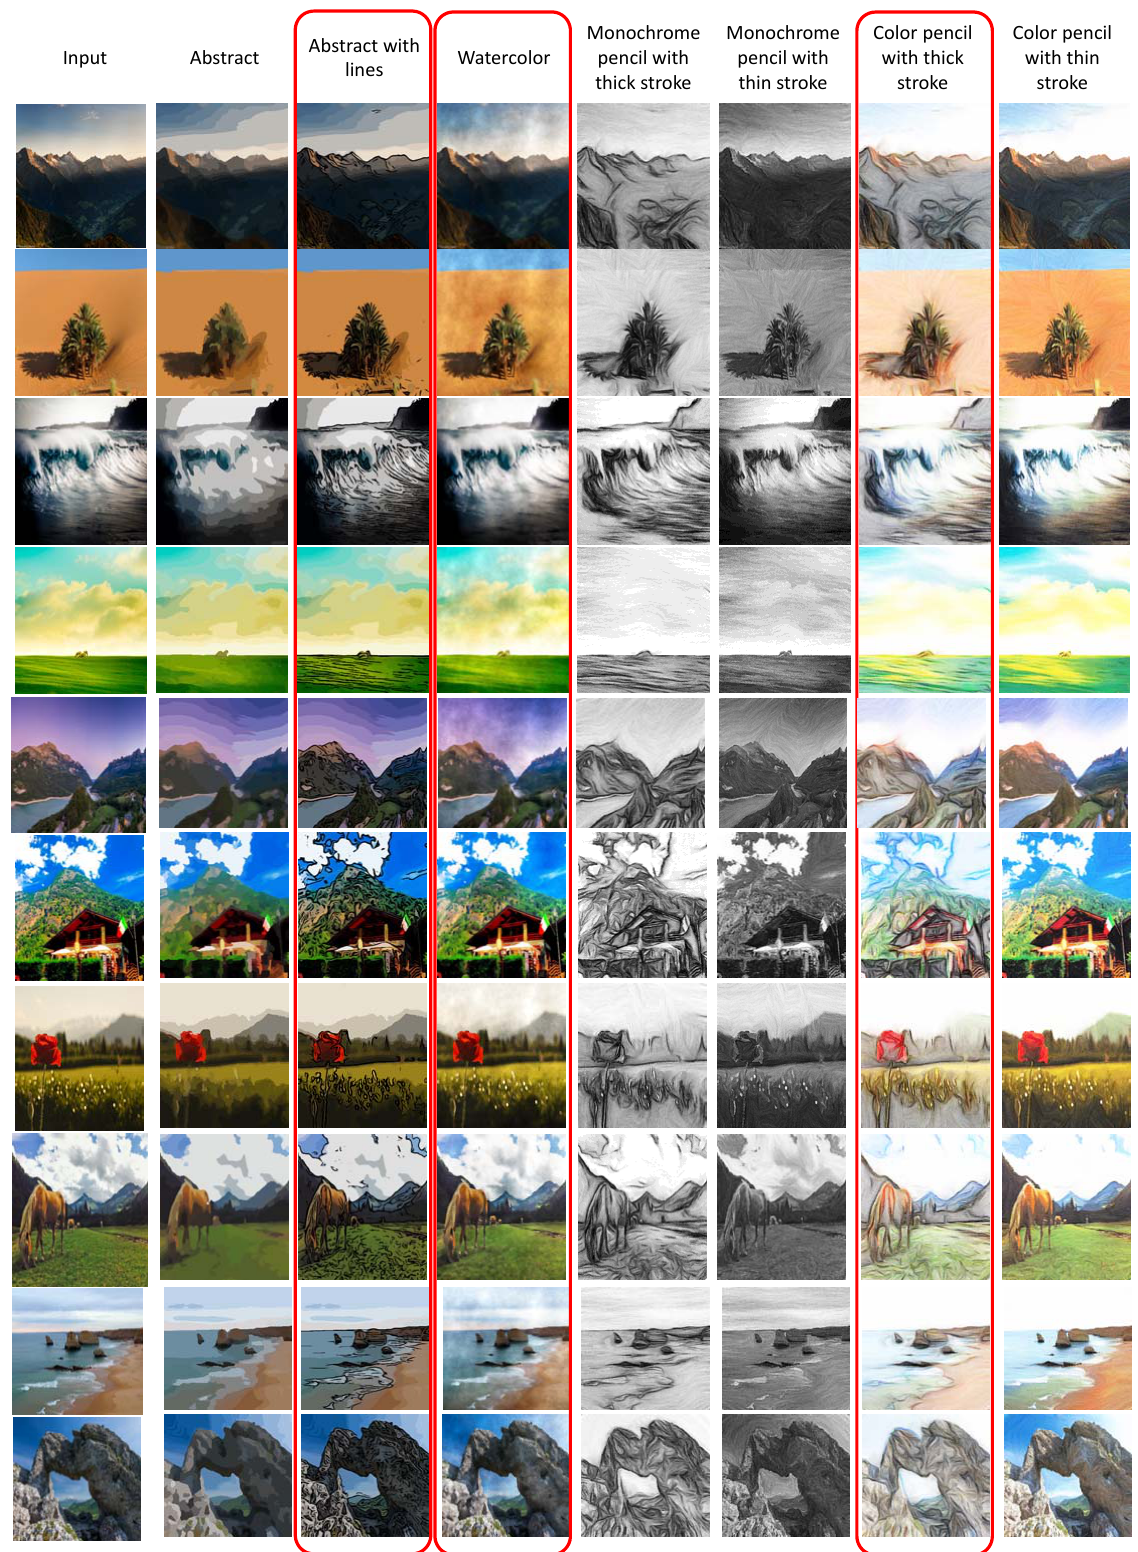
Figure 5. Training dataset produced using the existing techniques. Among the seven styles we can produce, we select three styles including abstraction with lines, watercolor and color pencil drawing with thick stroke for our dual style synthesis. The selected three styles are marked in red